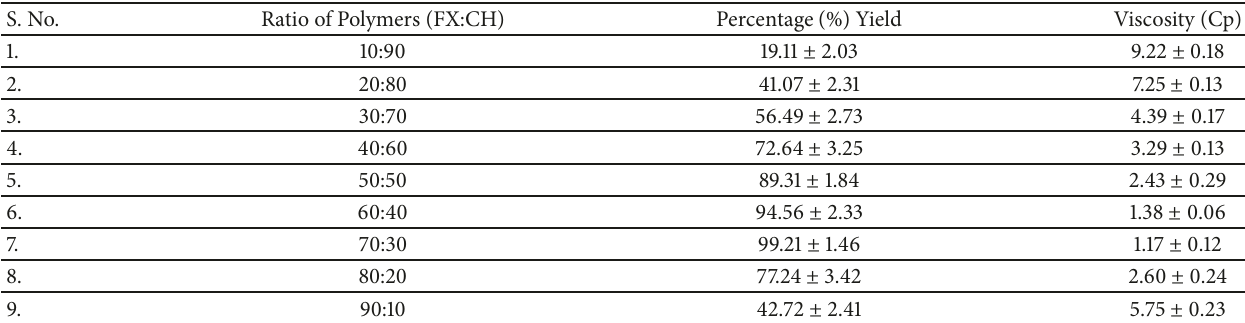
Table 2: Ratio of polymers with percentage yield and viscosity of FX-CH polyelectrolyte complexes. S.